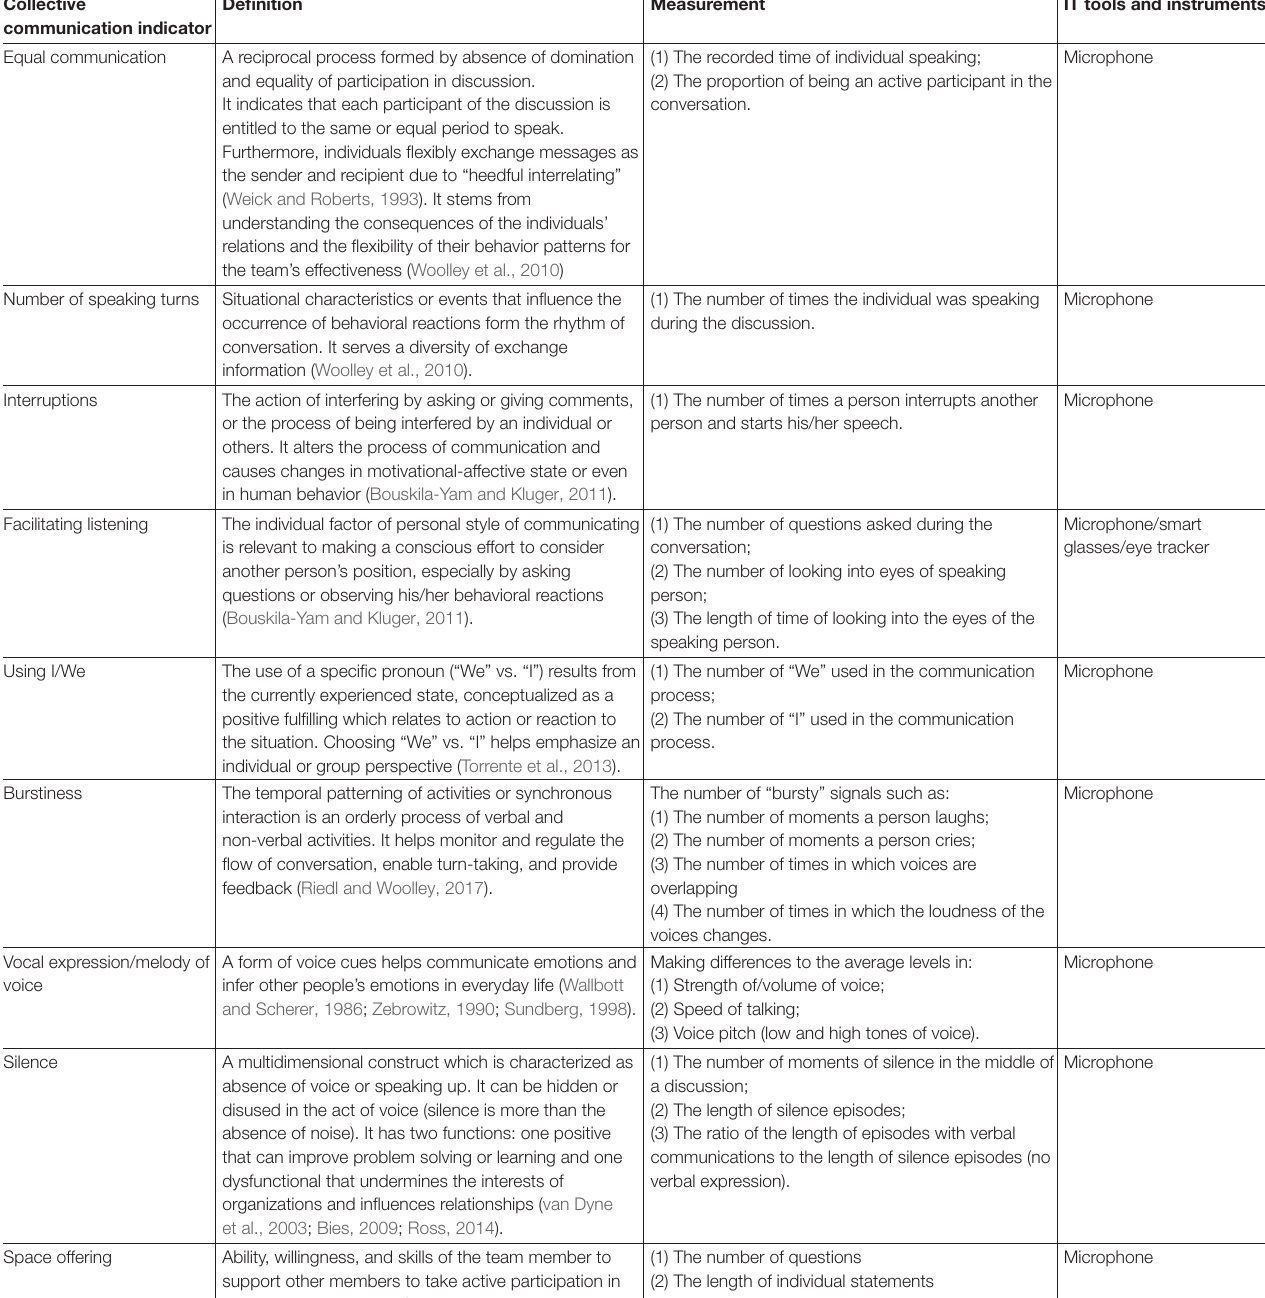
TABLE 5 | Definitions and measurement of collective communication enhancing team